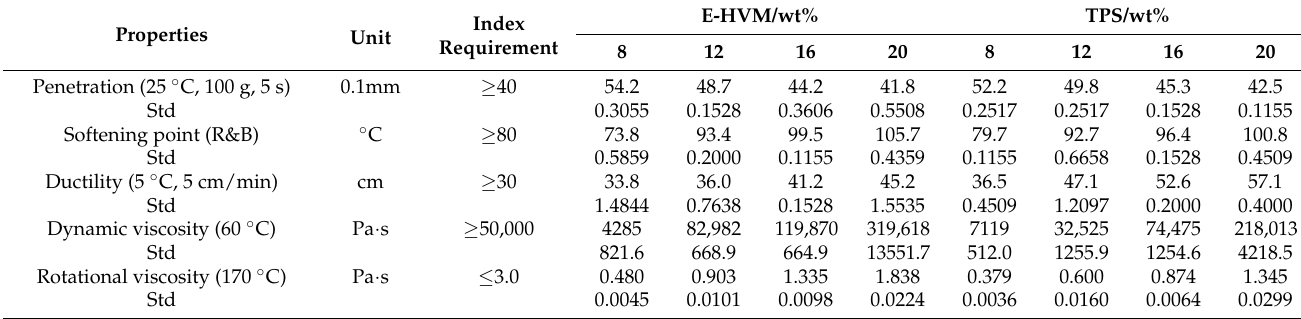
Table 5. Basic performance of